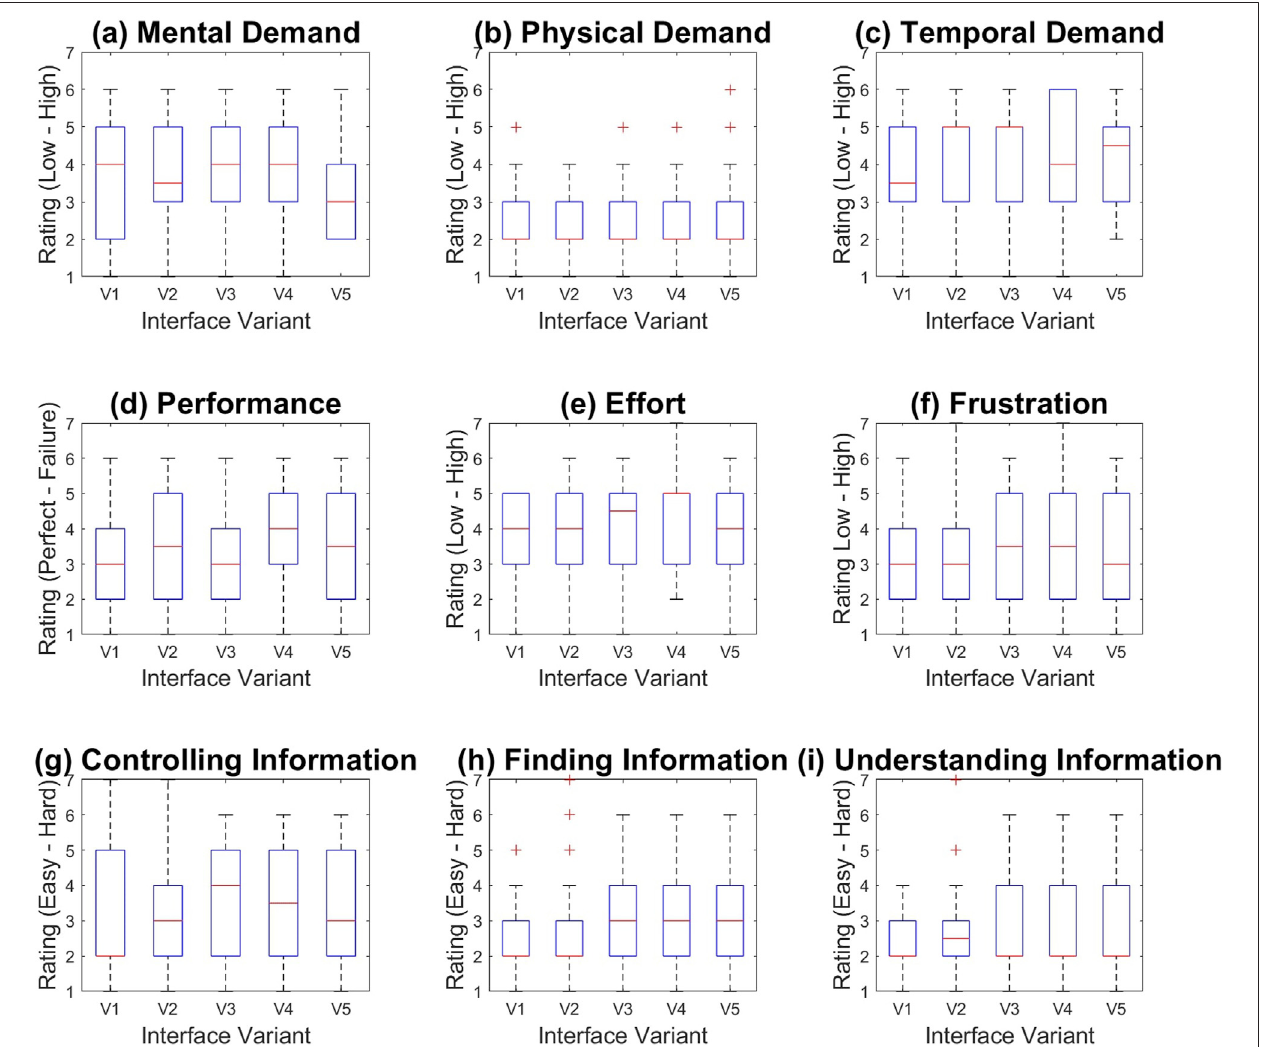
FIGURE 6 | Box and whisker graphs showing user feedback for the Interface Variants (V1 – V5) over 9 factors (A – I) .